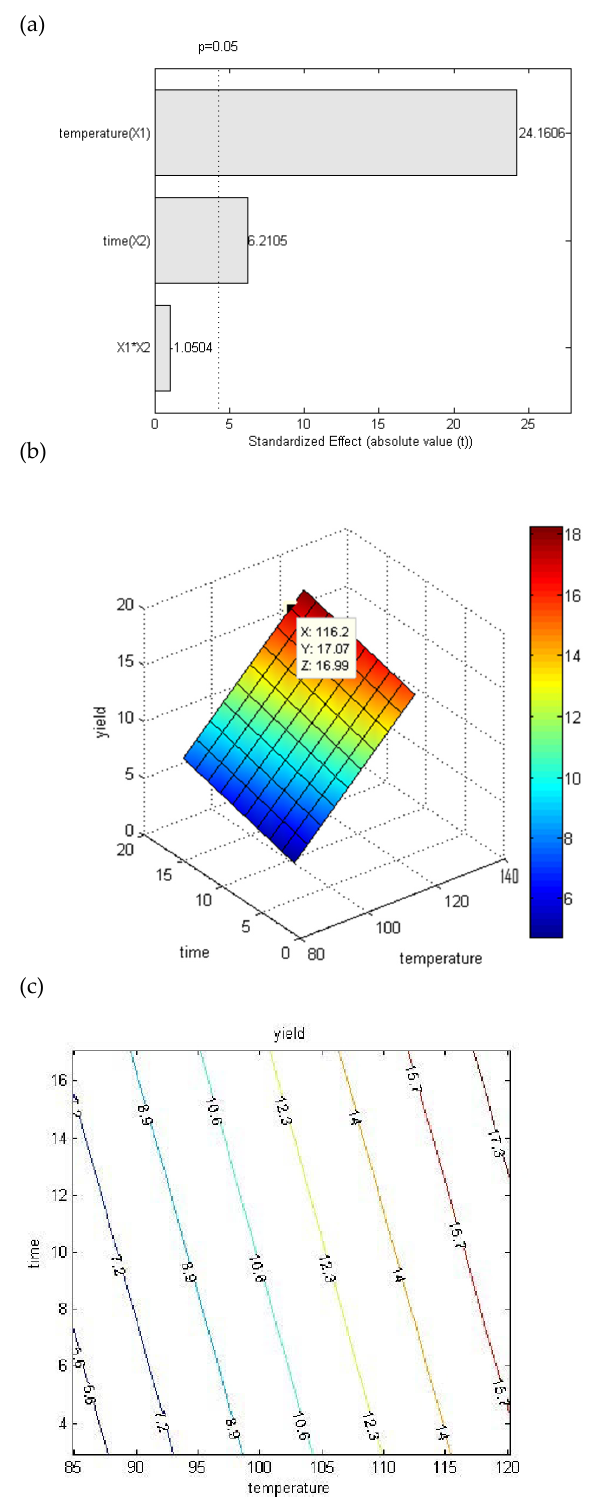
Figure 2. Optimization of CCP extraction from camelina cake. ( a ) Pareto chart graphically describing the effect of each variable or their interaction on CCP extraction yield. The vertical line indicated the significance of each effect ( p = 0.05). ( b ) Three-dimensional response surface plot (X—temperature, Y—minutes, Z—yield) and ( c ) contour plot for the interactive effects of extraction temperature (X1) and time (X2) in CCP extraction